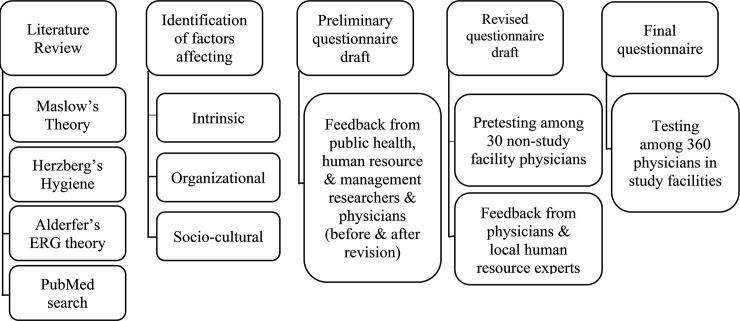
Summary of tool development and testing process.